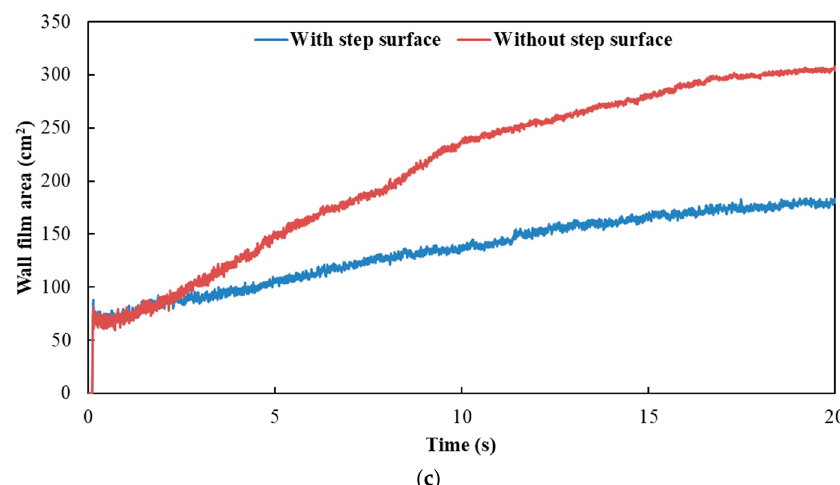
Figure 12. Influence of exhaust pipe with or without step surface on wall film area. ( a ) Case 1; ( b ) Case 2; ( c ) Case 3.